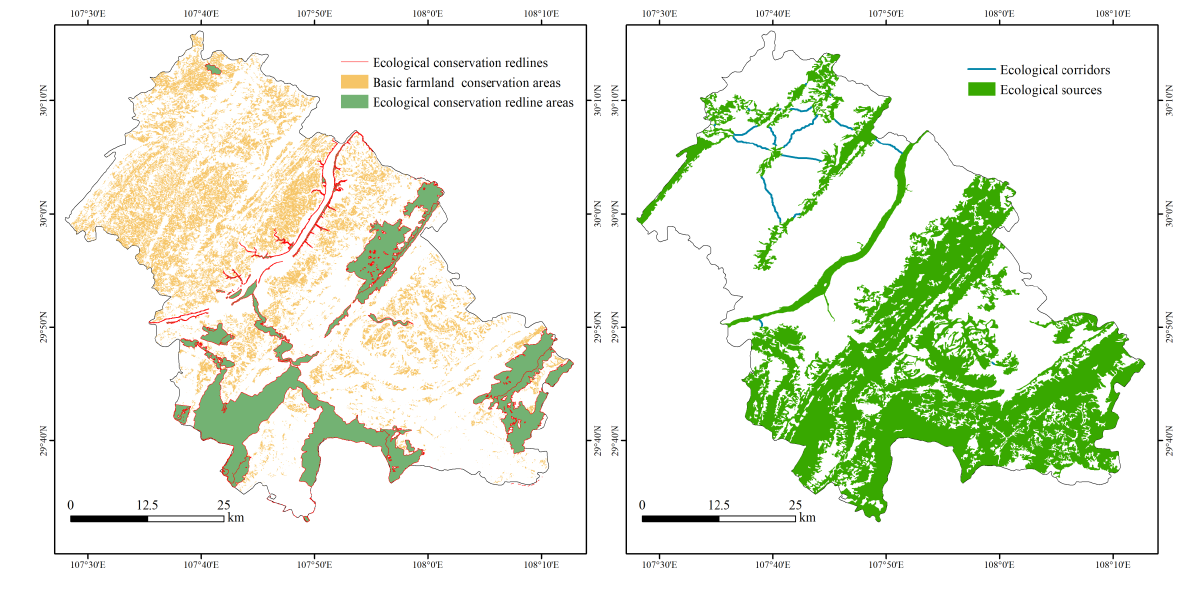
Figure A1. Spatial constraints area. Table A1. Neighborhood factor parameters.